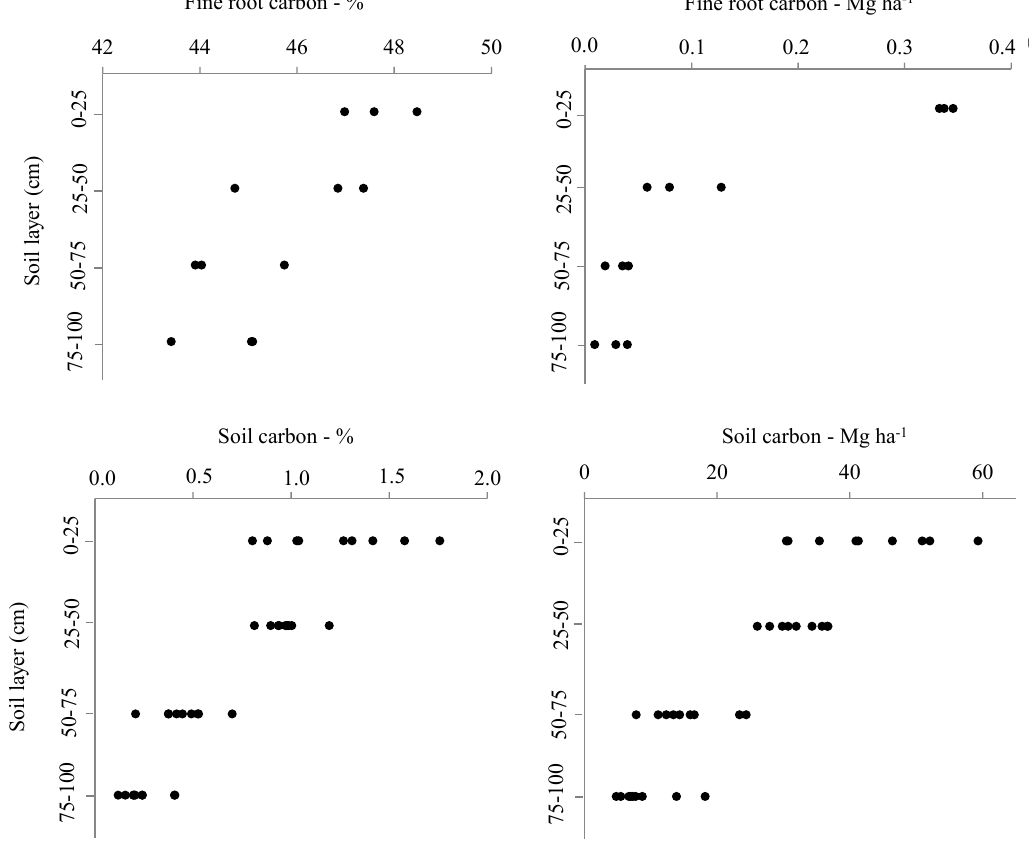
Figure 3. Carbon concentrations in the fine roots (diameter < 2.0 mm) and soil and in the 10-year-old Eucalyptus urophylla × Eucalyptus globulus stand.